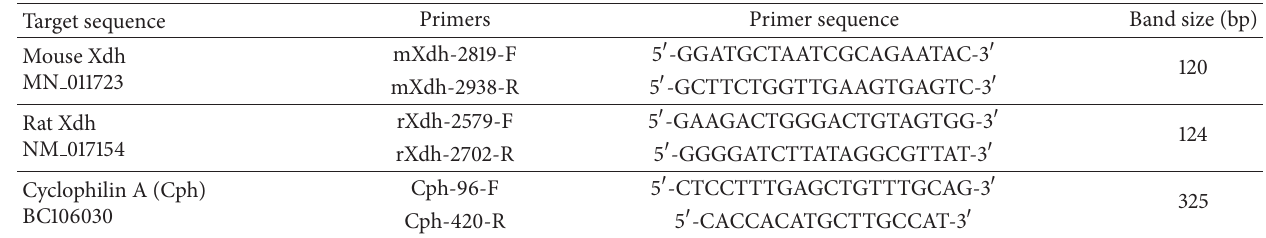
Table 1: Primers used for real-time RT-PCR.